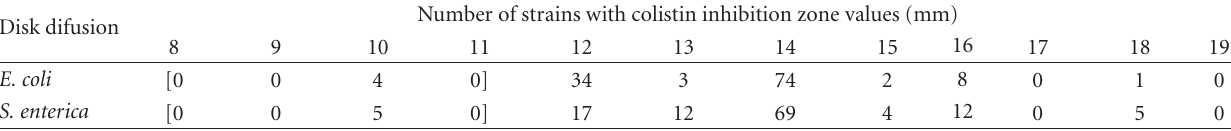
The values inside [] represent resistant strains. Table 2: Distribution of inhibition zone diameters swine E. coli and S. enterica strains through disk di ff usion test against colistin. Disk difusion